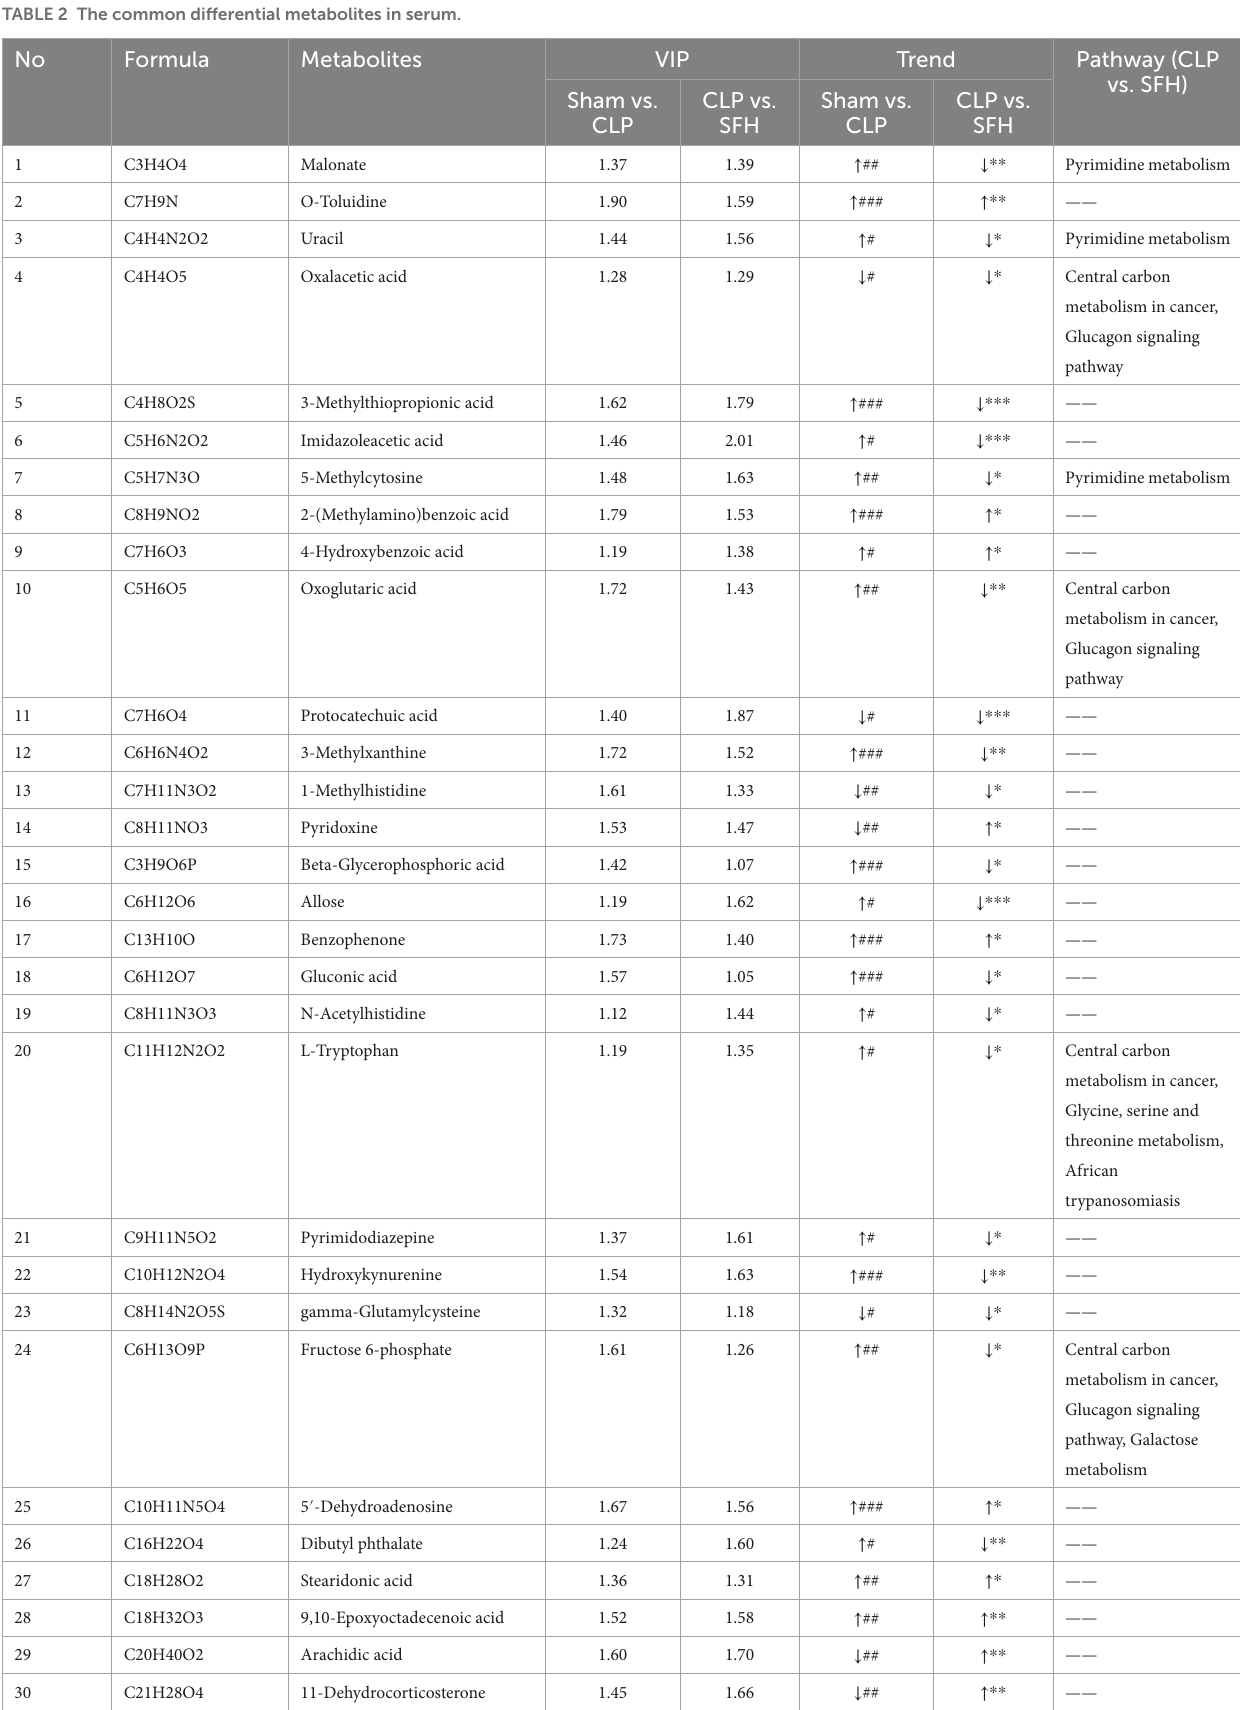
TABLE 2 The common differential metabolites in serum. No Formula Metabolites VIP Trend Pathway (CLP